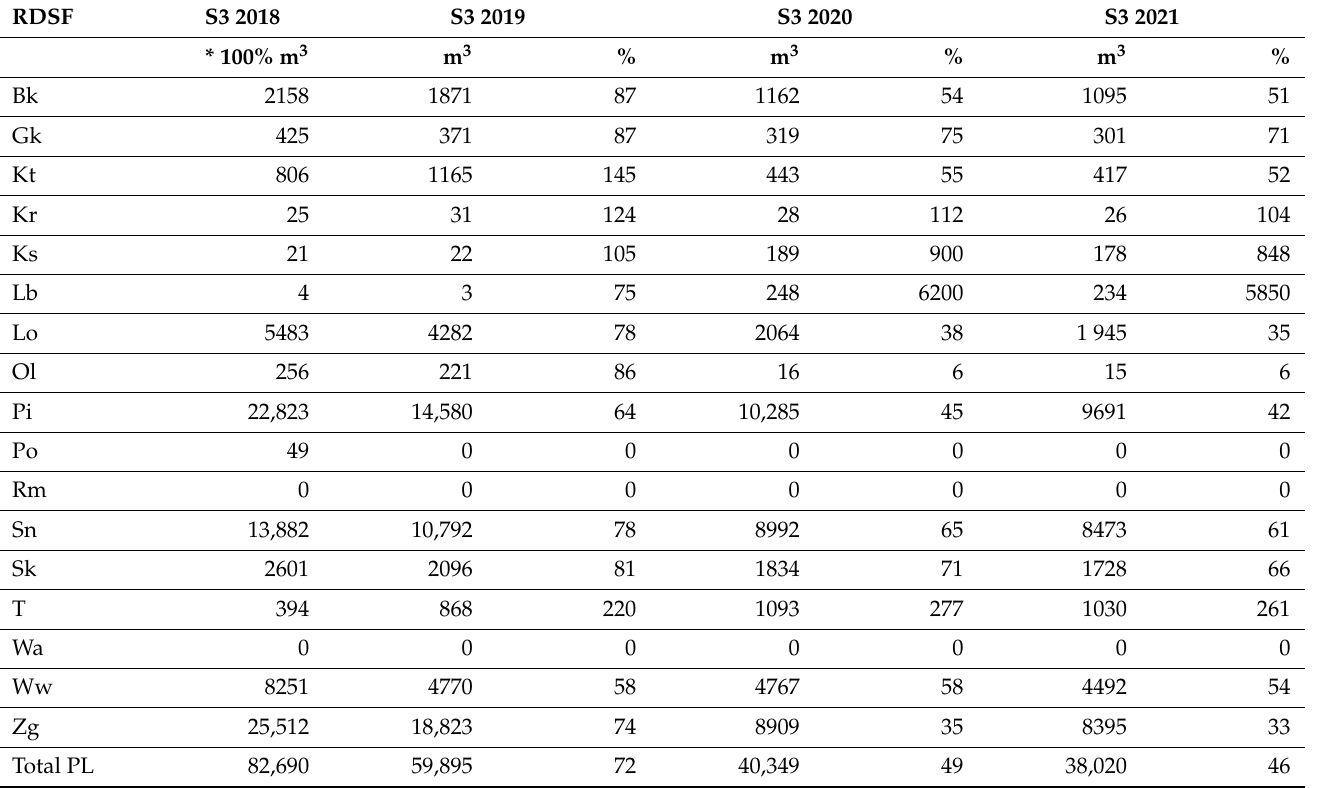
Table 7. Change in the structure of S3 woody biomass from 2018–2021.